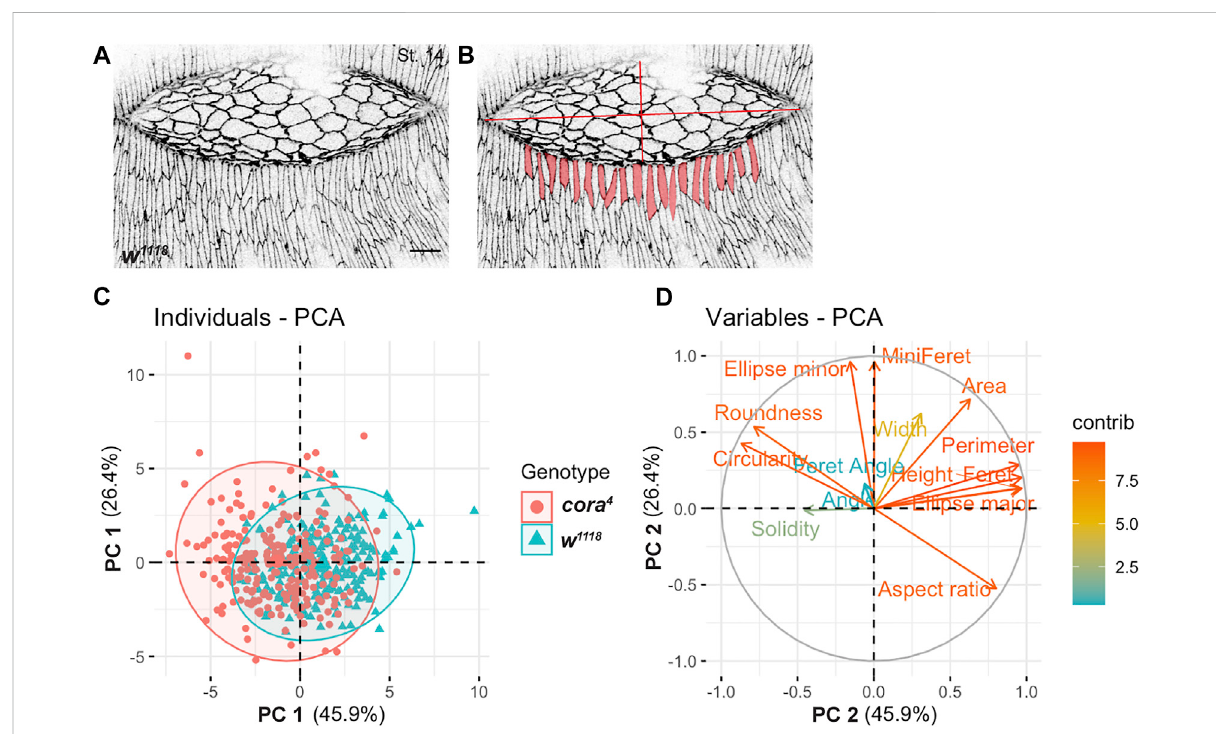
FIGURE 3 Principal Component Analysis (PCA) of cell shape. (A) Confocal optical section of a stage 14 wild type embryo stained with antibody against Ecad. (B) Segmented views of leading edge cells subjected to Fiji-based morphometric measurements. (C) Projection of individual cell shape measurements of lateral epidermal cells in stage 14 w 1118 (cyan) and cora 4 (red) across the two major principal components 1 (PC 1) and 2 (PC 2) revealed a large overlap with some regions of separation. (D) Contribution of 14 2D cell shape variables to the two principal components (on a scale of 0 – 12) showed a greater in fl uence of height, ellipse major, perimeter, aspect ratio, roundness and circularity on PC 1 and ellipse minor and area on PC 2. Scale bar = 10 µm.